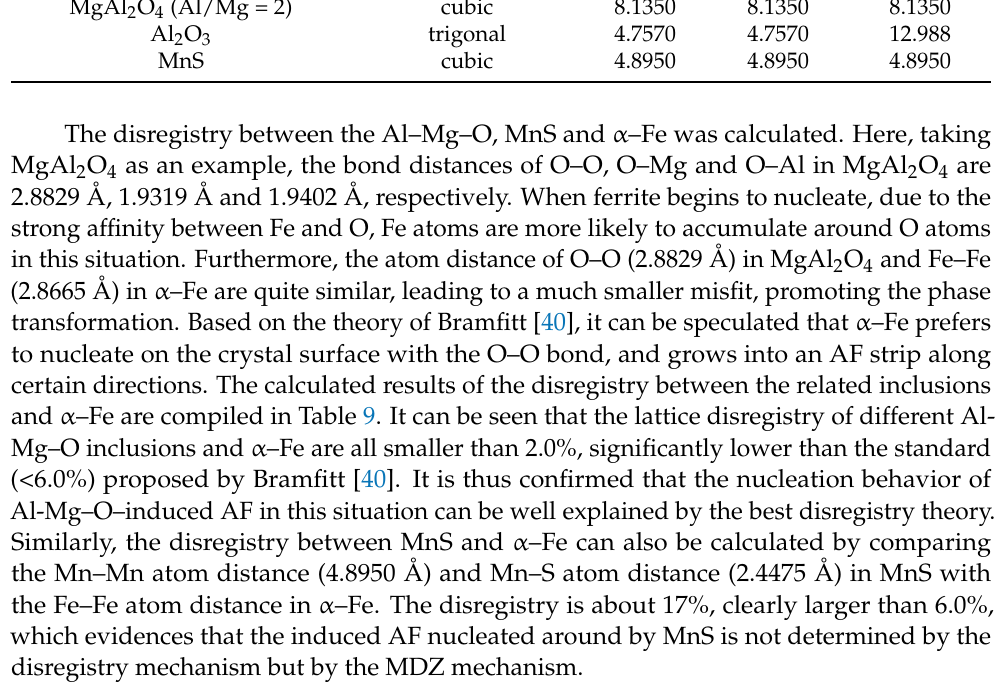
Table 9. Results of the disregistry between the related inclusions and α -Fe.